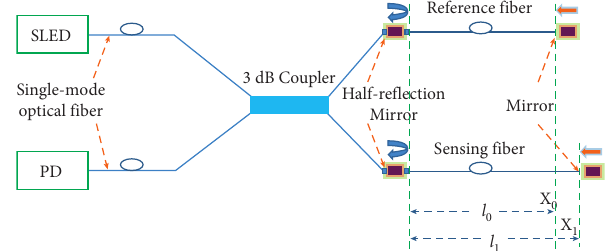
Figure 1: Typical experimental setup of the WLI sensing technique.